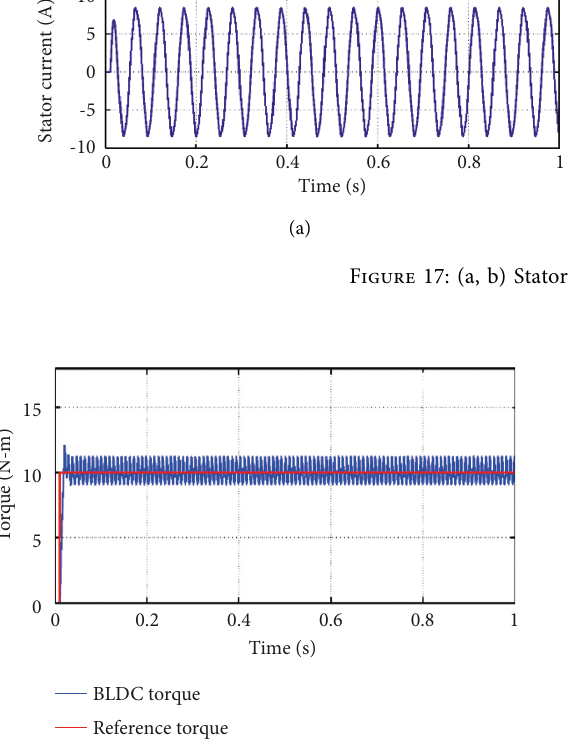
Figure 18: Electromagnetic torque T